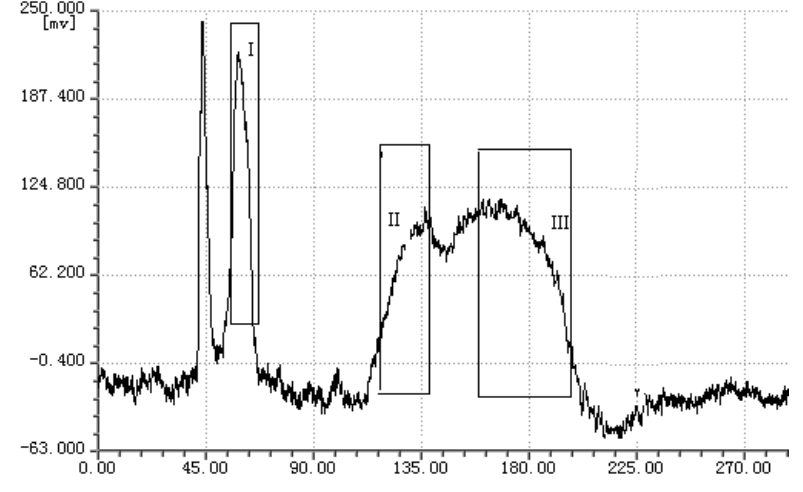
Figure 3. HSCCC chromatography of the crude extract from R . japonicus